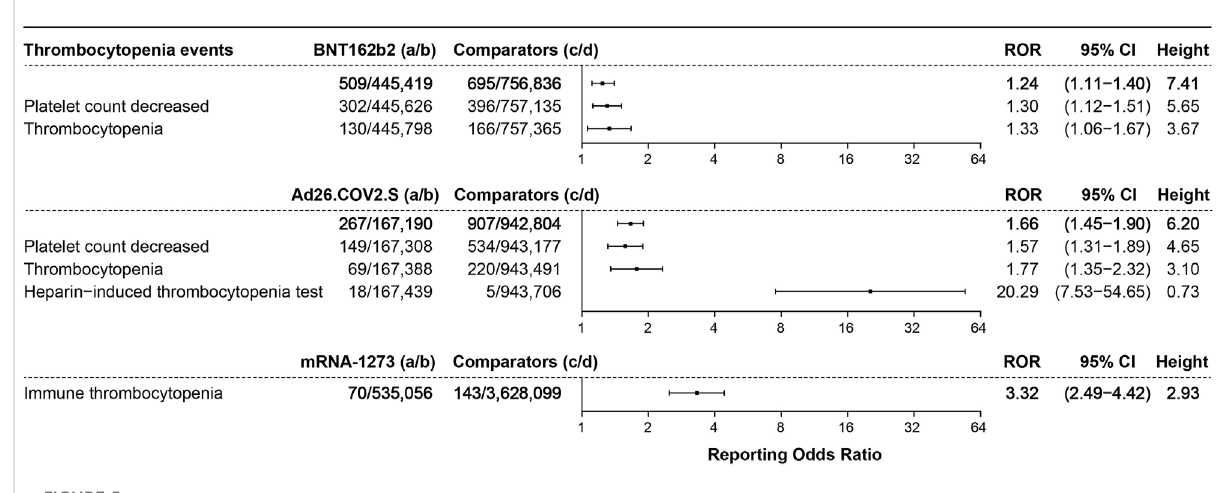
FIGURE 5 ROR values and height of the COVID-19 vaccines of BNT162b2-, Ad26.COV2.S-, and mRNA-1273-associated thrombocytopenia events. a: cases oftarget thrombocytopeniaevents reported concerning thetarget COVID-19 vaccines; b: cases ofother adverse events reported concerning the target COVID-19 vaccines; c: cases of target thrombocytopenia events reported concerning all the other vaccines; d: cases of other adverse events reported concerning all the other